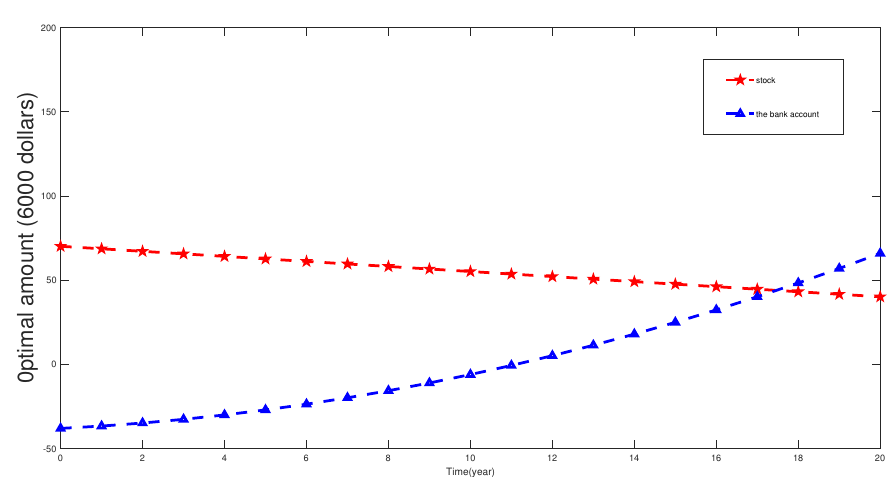
Figure 5. Optimal amount with inflation.